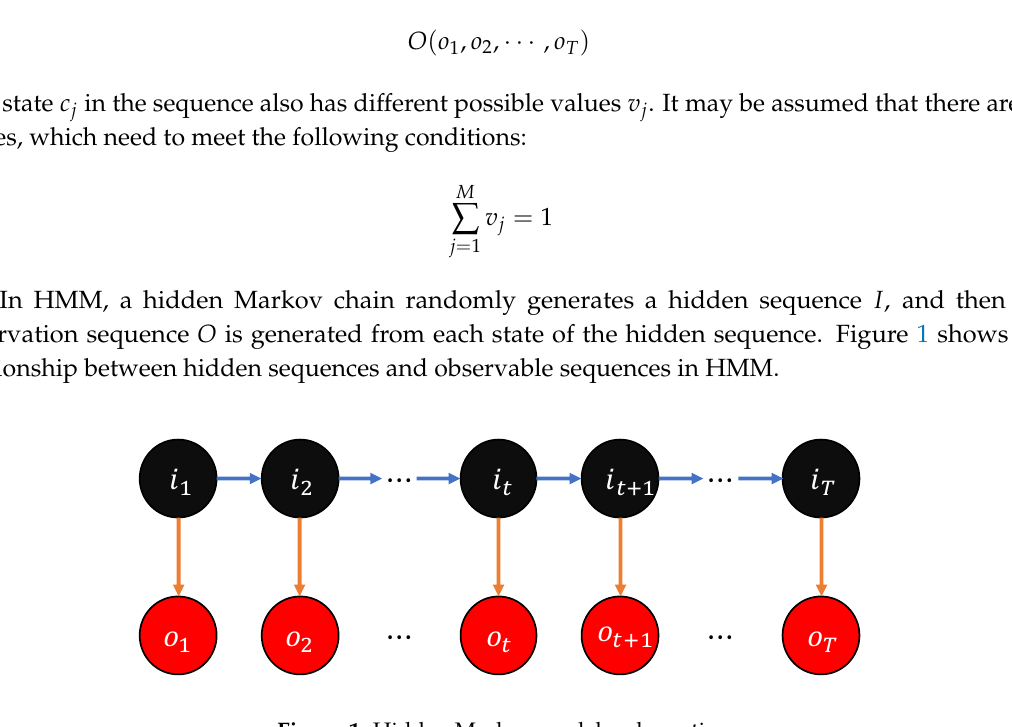
Figure 1. Hidden Markov models